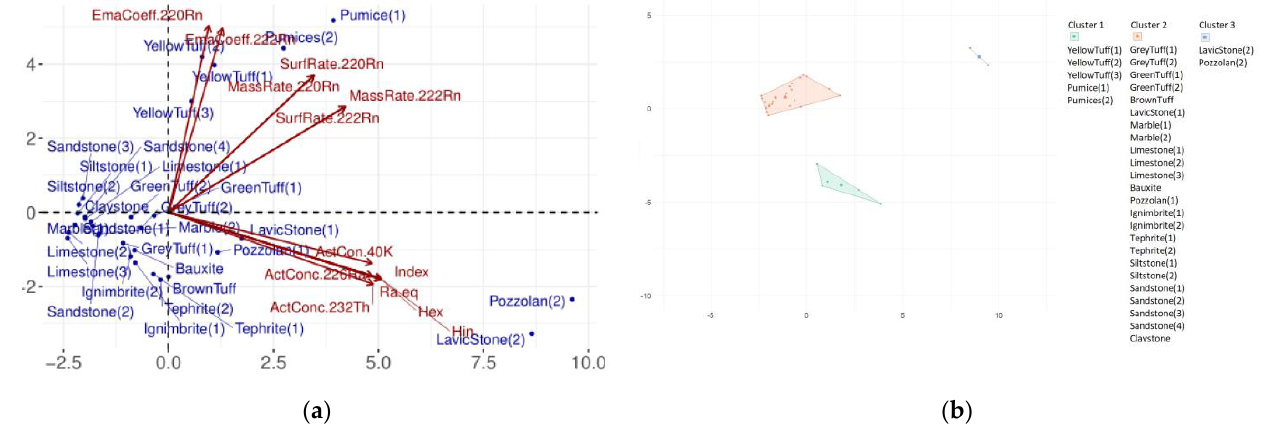
Figure 4. ( a ) The plot of Figure 3a combined with the representation of the parameters to highlight the influence of each on the materials. ( b ) Representation of the three clusters into which the materials were divided by the k-means partition analysis based on their similarity.